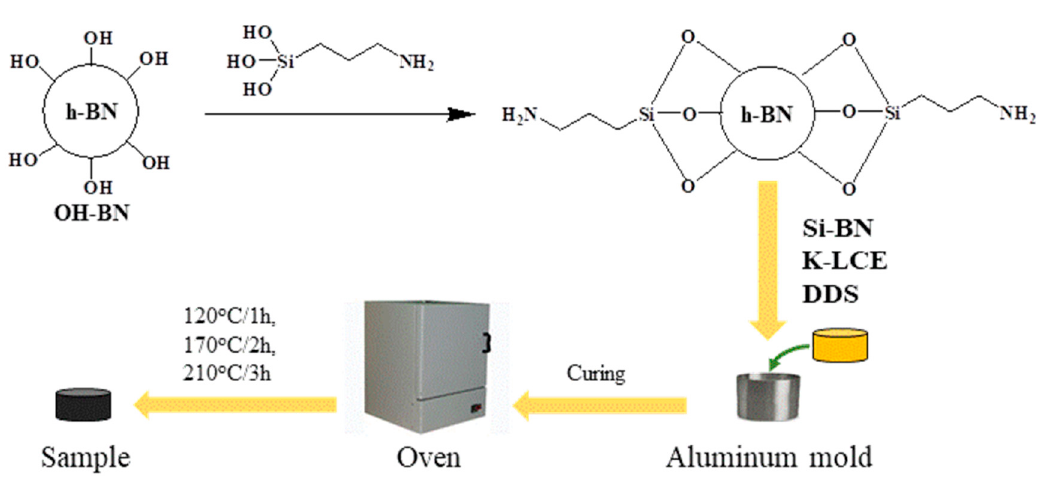
Figure 1. Process of the K–LCE / boron nitride (BN)composites fabrication.